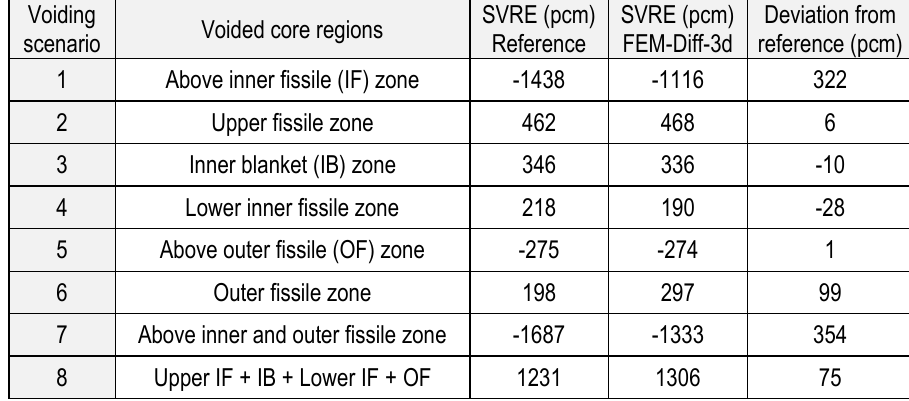
Table 2. Sodium void rectivity effects (SVRE) obtained for different voiding